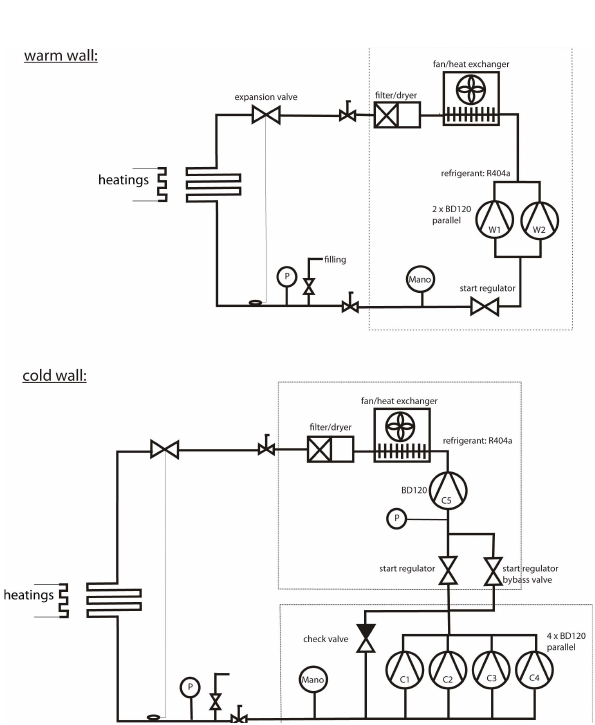
Fig. 1. Schematic of the cooling system in PINC.